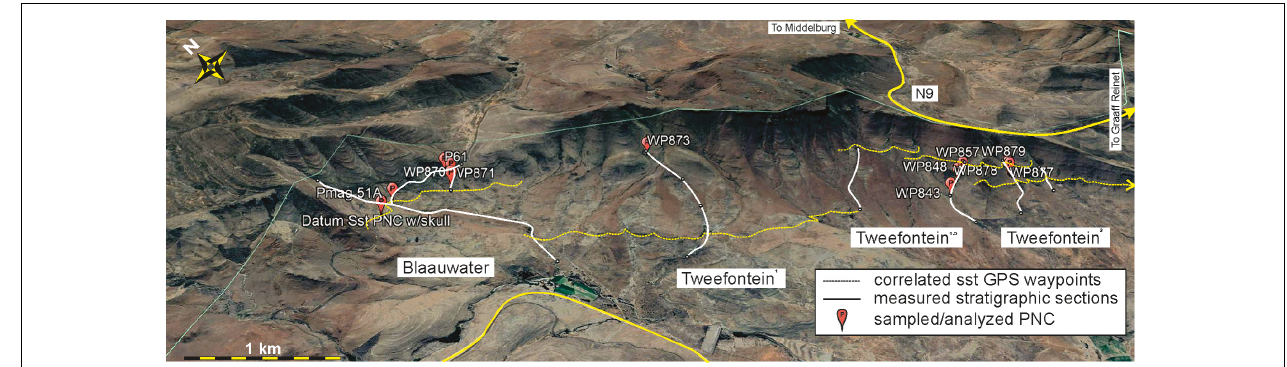
FIGURE 3 | Six of the measured sections at Old Lootsberg Pass to Tweefontein 2 (white solid lines; Figure 2 ) plotted on an oblique GoogleEarth image showing their spatial relationship relative to topography. Yellow dotted lines are laterally traceable sandstone-channel deposits, waypointed and used as datums for correlation across the area ( Figure 4 ). Sampled intraformational pedogenic nodule conglomerates (PNC), identified with their waypoint (WP) designation, appear as red balloons. Scale = 1